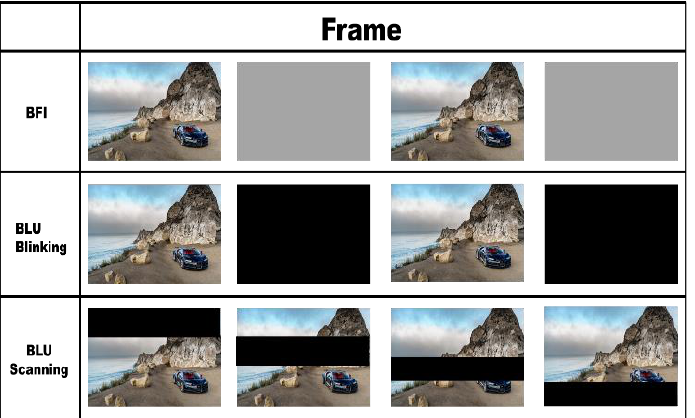
refresh delay depends on the LC characteristics, which is different from each panel. After these delay times is the PWM driving period, which can realize different gray levels. Figure 6. Comparison between traditional BFI, BLU blinking and proposed BLU scanning MPRT improvement method.